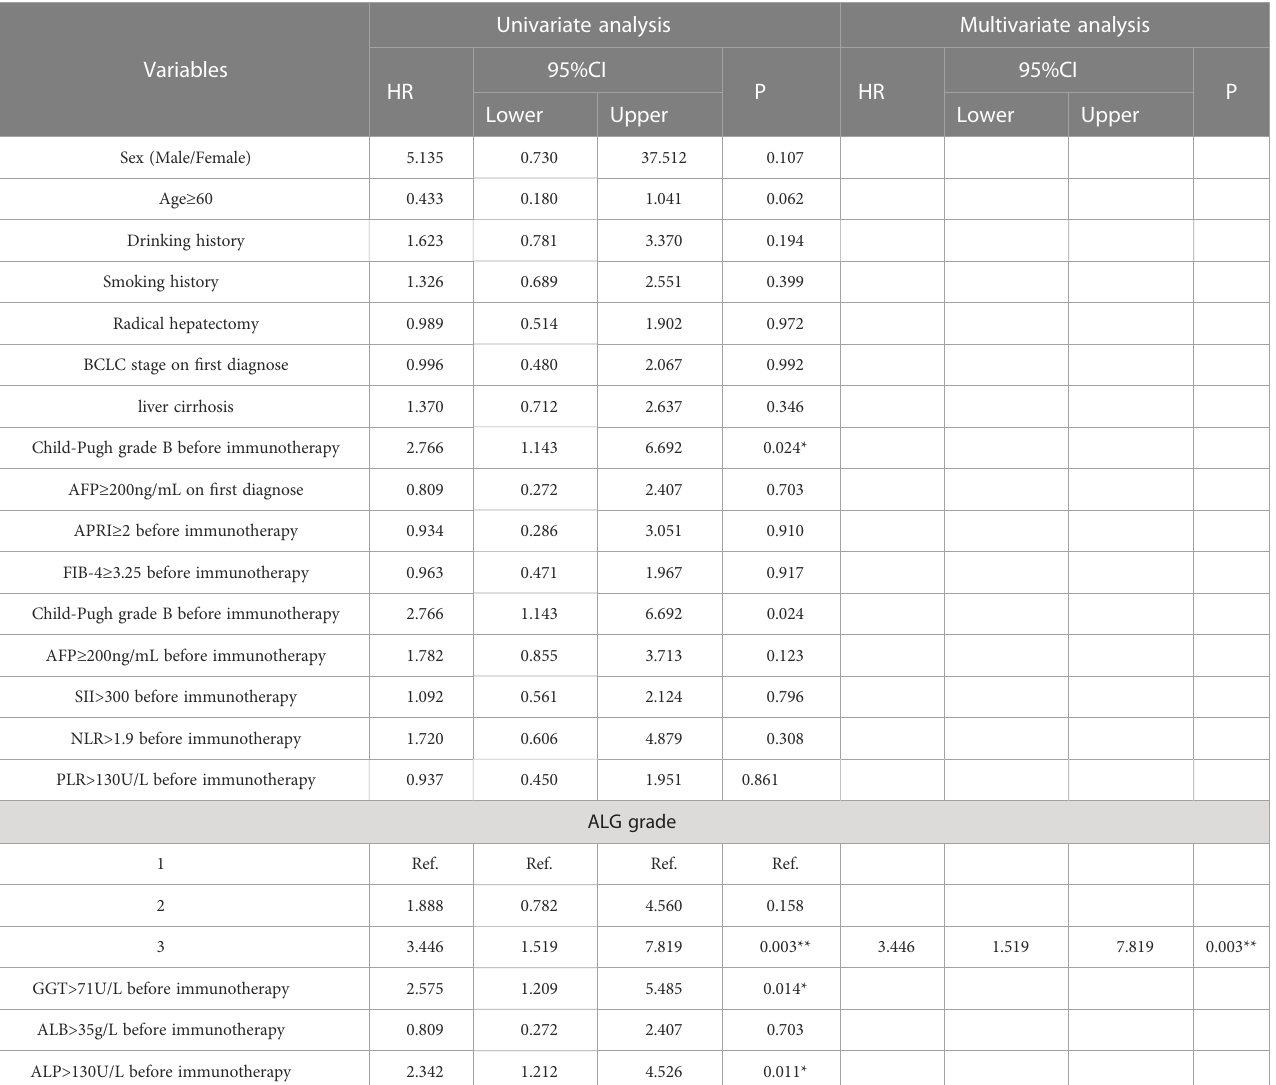
TABLE 3 Cox regression analysis of PFS for patients receiving